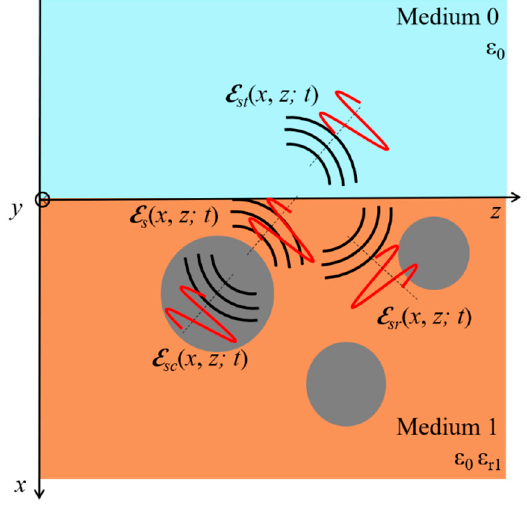
Figure 2. Decomposition of the scattered fields.